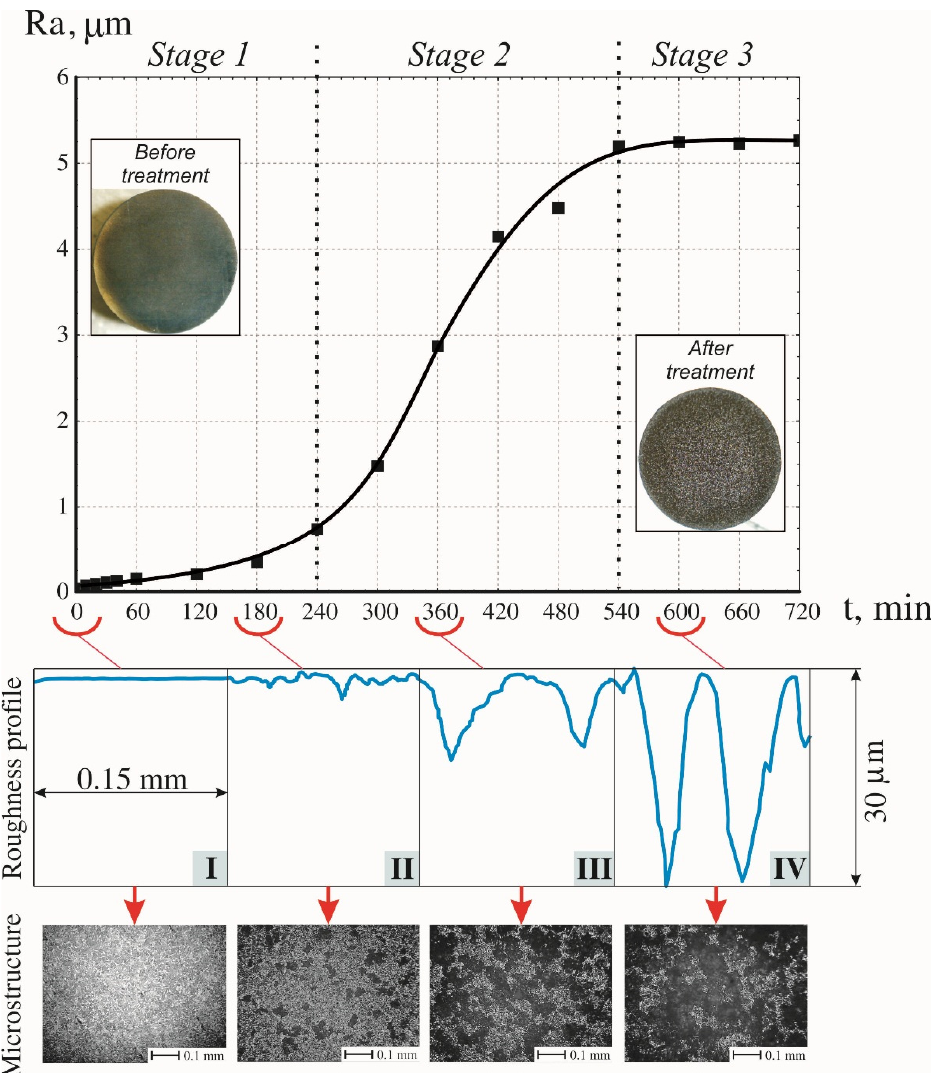
Figure 5. Dynamics of changes in roughness, Ra, for 40Kh steel. Comparing the dynamics of the Ra parameter with the progress of surface erosion, a number of features can be identified: